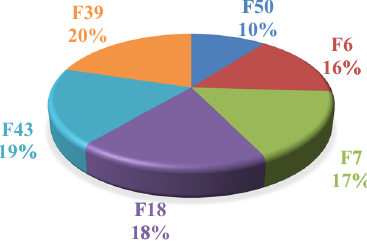
Figure 9: Local impact of factors in the handover